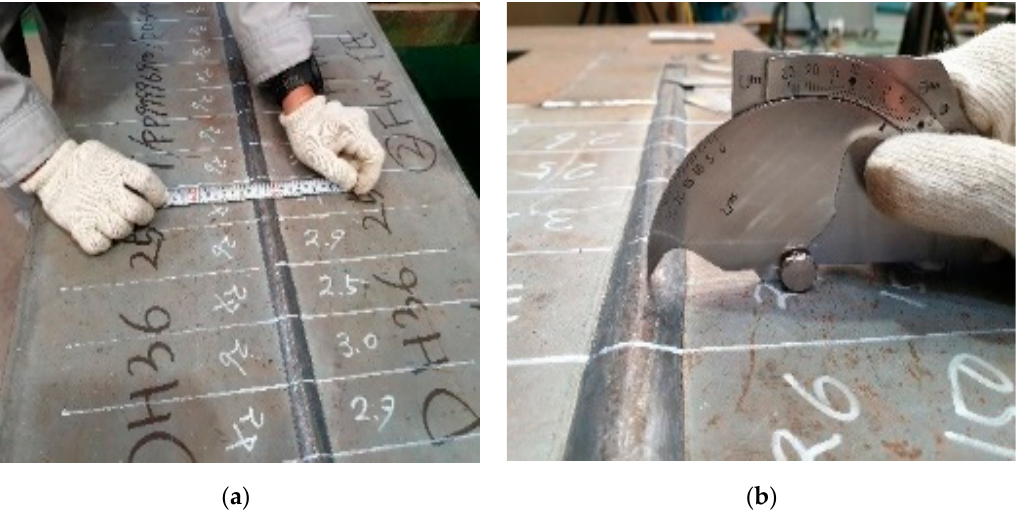
Figure 7. Measurement of the weld bead height and width: ( a ) measurement of width; ( b ) measure- ment of height.